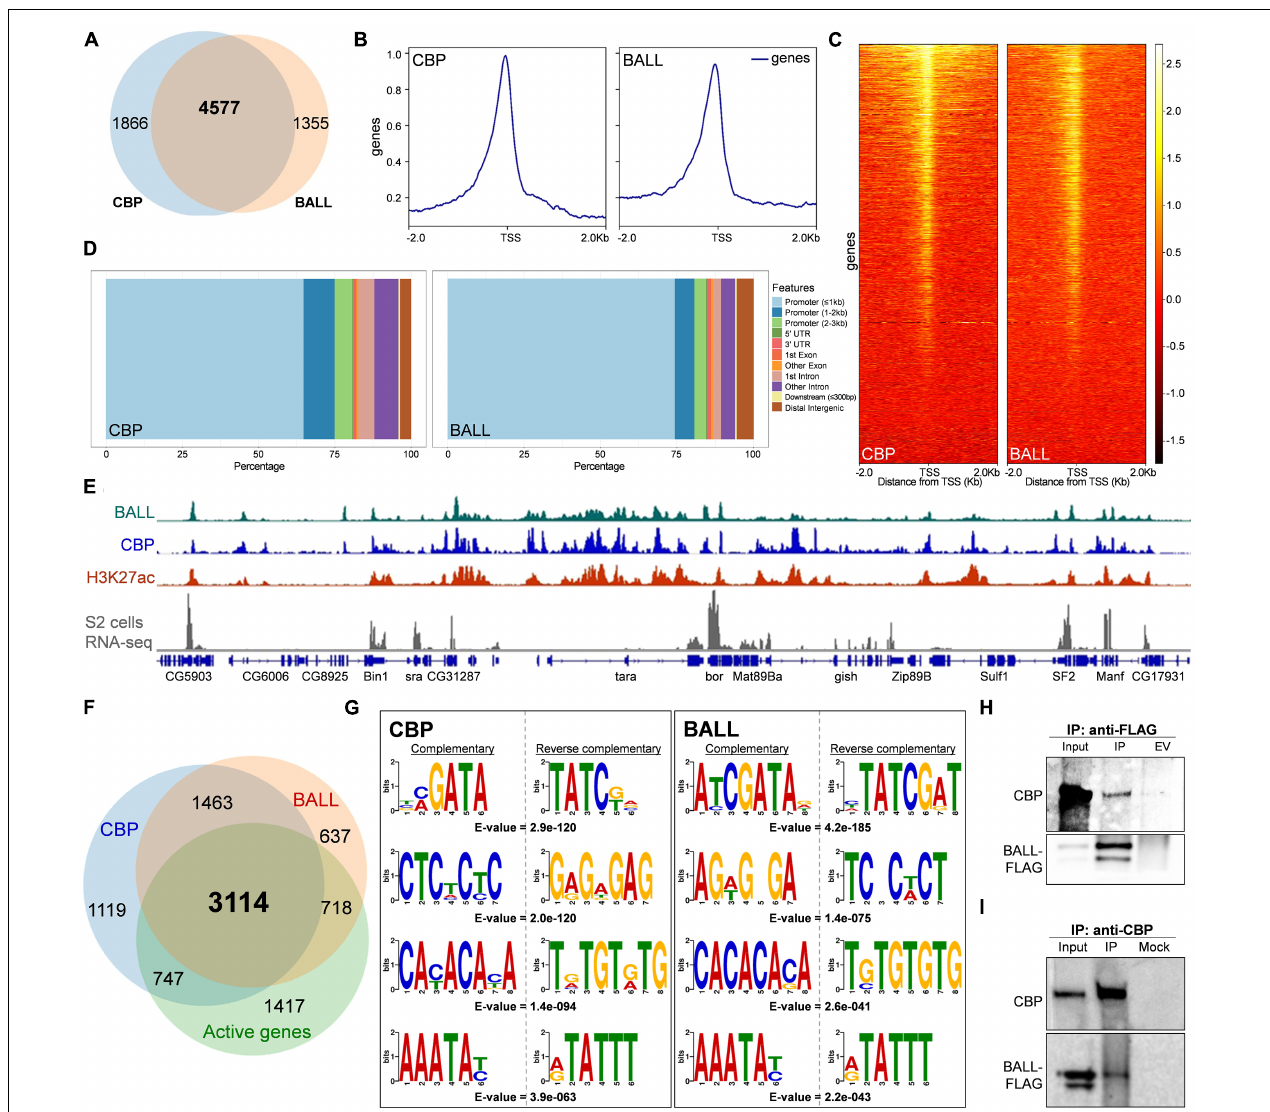
FIGURE 1 | Genome-wide occupancy of BALL, CBP, and their biochemical interaction in Drosophila S2 cells. (A) Venn diagram depicting substantial overlap between CBP and BALL bound genes in S2 cells. Both BALL and CBP are co-bound at 4577 genes. (B,C) Comparison of genome-wide occupancy of CBP and BALL reveals an enormous similarity. Both CBP and BALL preferentially bind chromatin upstream to the TSS (B) . Heat maps covering ± 2 Kb region from TSS illustrate CBP and BALL occupancy across the genome (C) . CBP and BALL mainly co-occupy the regions from TSS to 1 Kb upstream. (D) Percentage distribution of CBP and BALL binding across different genome features shows a similar pattern where both CBP and BALL mainly reside in promoter regions. (E) Integrated genome browser view of the ChIP-seq data shows overlap between chromatin binding profiles of BALL (top panel), CBP (middle panel) and H3K27ac (lower panel). Genes co-occupied by BALL and CBP display active transcription as inferred by RNA-seq analysis of S2 cells (bottom panel). (F) Venn diagram depicting CBP and BALL enriched genes overlaid with actively transcribed genes in S2 cells. Majority of the genes that were co-bound by CBP and BALL were found to be transcriptionally active. (G) Four of the top five short DNA binding motifs within CBP associated chromatin, generated from MEME-ChIP database, show-striking similarity with the similar motifs within BALL bound chromatin. Each motif is presented with its respective reverse complementary motif and E -value. (H) Immunoblots of endogenous CBP and FLAG-tagged BALL after co-immunoprecipitation (IP) using anti-FLAG antibody in Drosophila S2 cells containing inducible BALL-FLAG. As compared to IP from empty vector (EV) control cells, noticeable enrichment of CBP can be seen in IP using anti-FLAG antibody, which also resulted in enrichment of FLAG-BALL. (I) Immunoblots of endogenous CBP and FLAG-tagged BALL after co-immunoprecipitation (IP) using anti-CBP antibody in Drosophila S2 cells. BALL-FLAG is enriched after IP with anti-CBP antibody as compared to mock IP used as negative control. Enrichment of CBP validates successful IP.